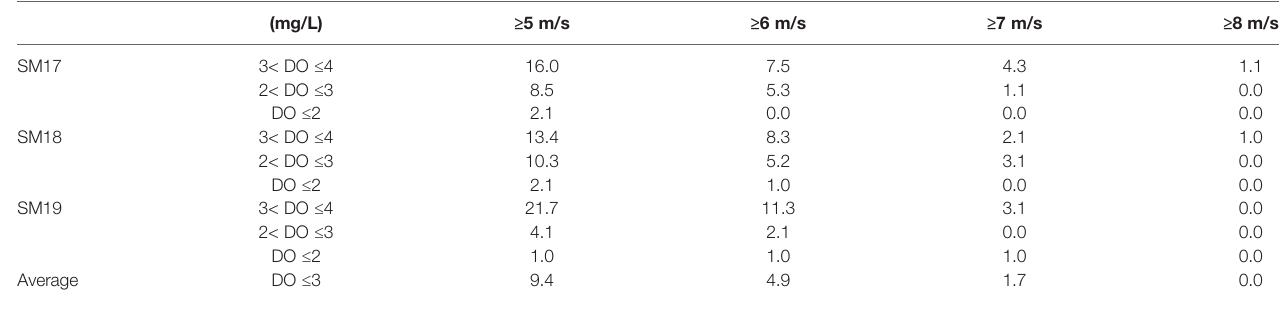
TABLE 3 (A) | The Frequency (%) of bottom DO at different V 7 Wind Speeds during 1990-2018 in summer.